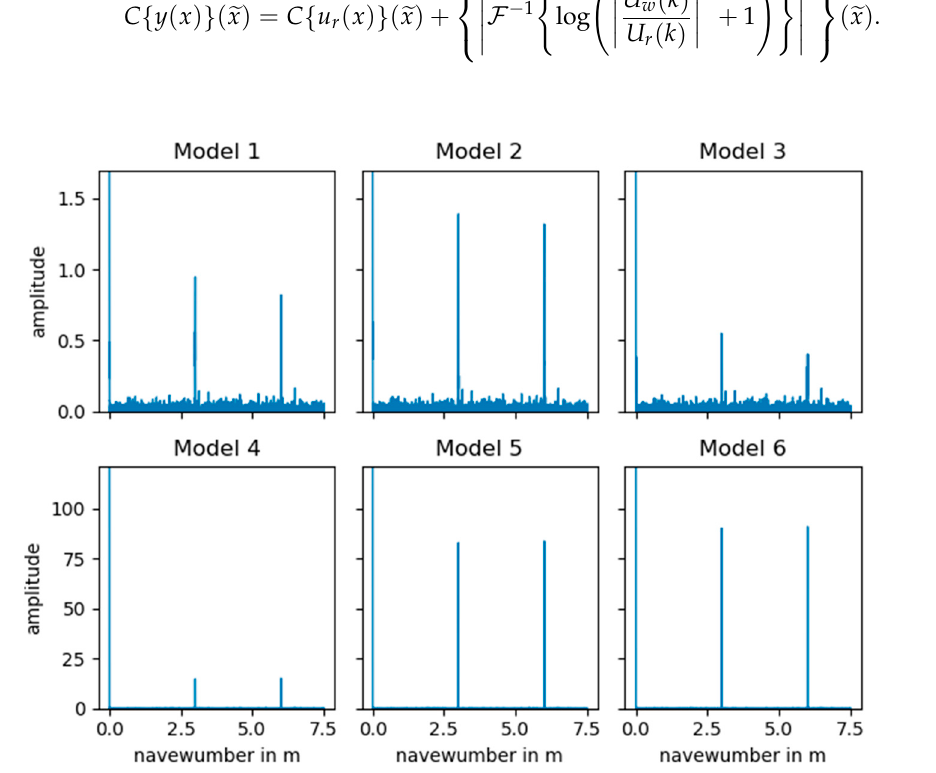
Figure 2. Cepstra of the synthetic data generated of the different models.